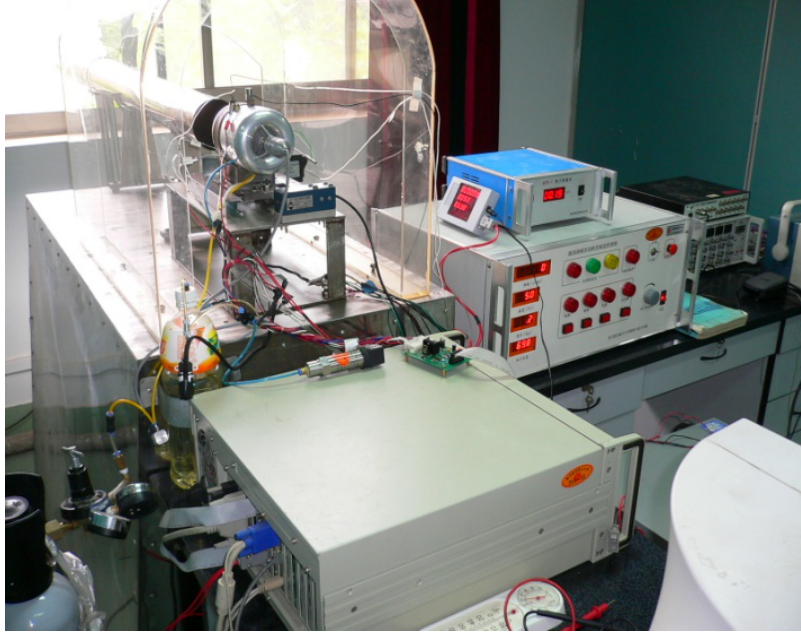
Figure 3. Test environment for the